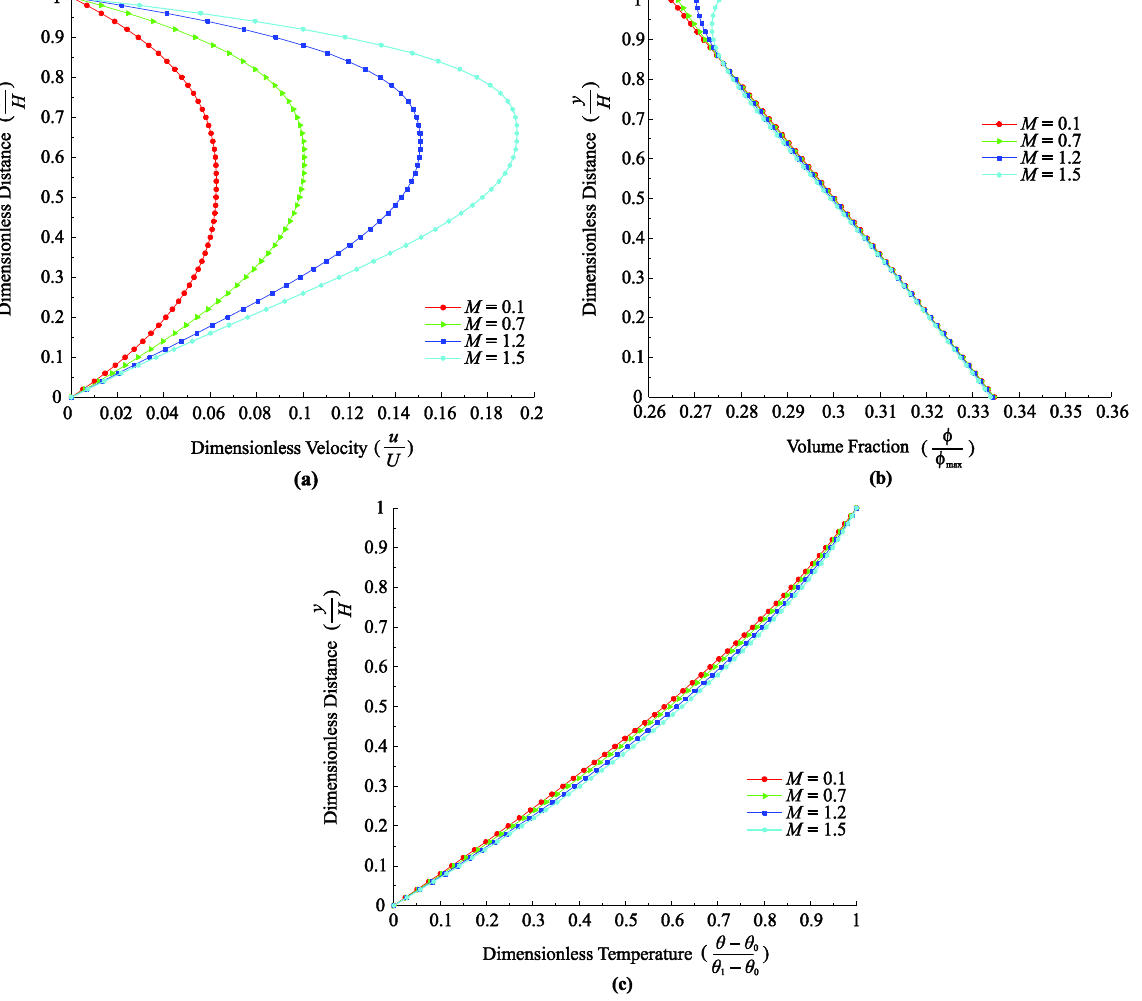
Figure 5. ( a ) Effect of M on the dimensionless velocity distribution. ( b ) Effect of M on the volume fraction distribution. ( c ) Effect of M on the temperature distribution. 𝑚 = −0.3, 𝐵 = −2, 𝐵 = 0.01, 𝐵 = 10, 𝐵 = 0.1, 𝑇 = 1.5, 𝑁 = 0.3, 𝑅 1 2 3 4 −0.02, 0.01, 2.3, −9, 11